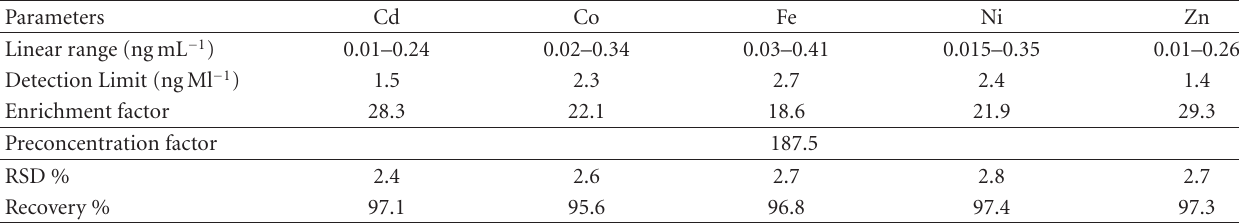
Table 4: Specification of presented method at optimum conditions for each